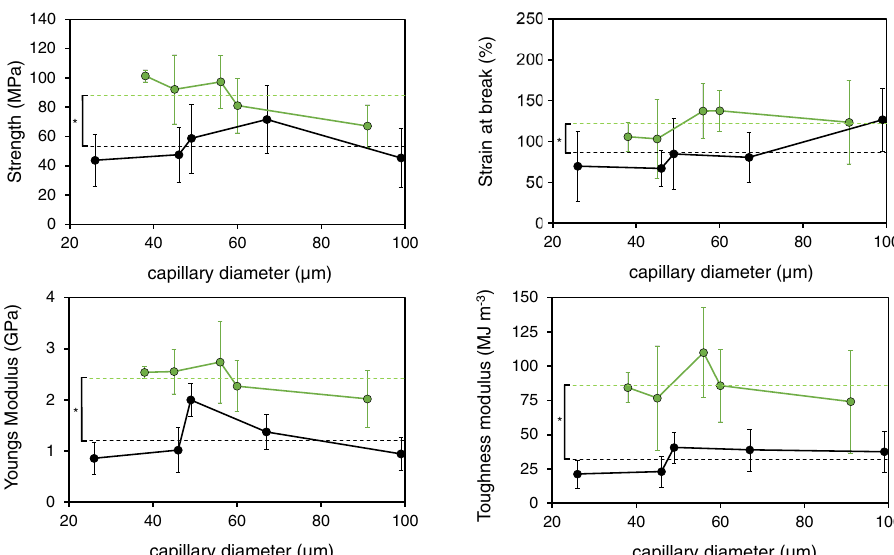
Fig. 2 Impact of capillary tip diameter on the mechanical properties of arti fi cial NT2RepCT silk fi bers. Capillaries with six different tip diameters were tested with and without NaCl in the spinning buffer, respectively. The black line connects the data points obtained when a 750 mM acetate (Na)spinning buffer containing 200 mM NaCl was used. The green line represents data points that were obtained with a 750 mM acetate (Na) spinning buffer without NaCl. Each data point represents the average of n ≥ 10 measurements, with error bars showing ± one standard deviation. The corresponding stress-strain curves are shown in Supplementary Fig. 1. The dashed lines in Fig. 2 show the average of all data points for the spinning buffer with NaCl (black) or without NaCl (green). Stars indicate a signi fi cant difference ( p < 0.01). Detailed spinning parameters for this experiment are found in Supplementary Table